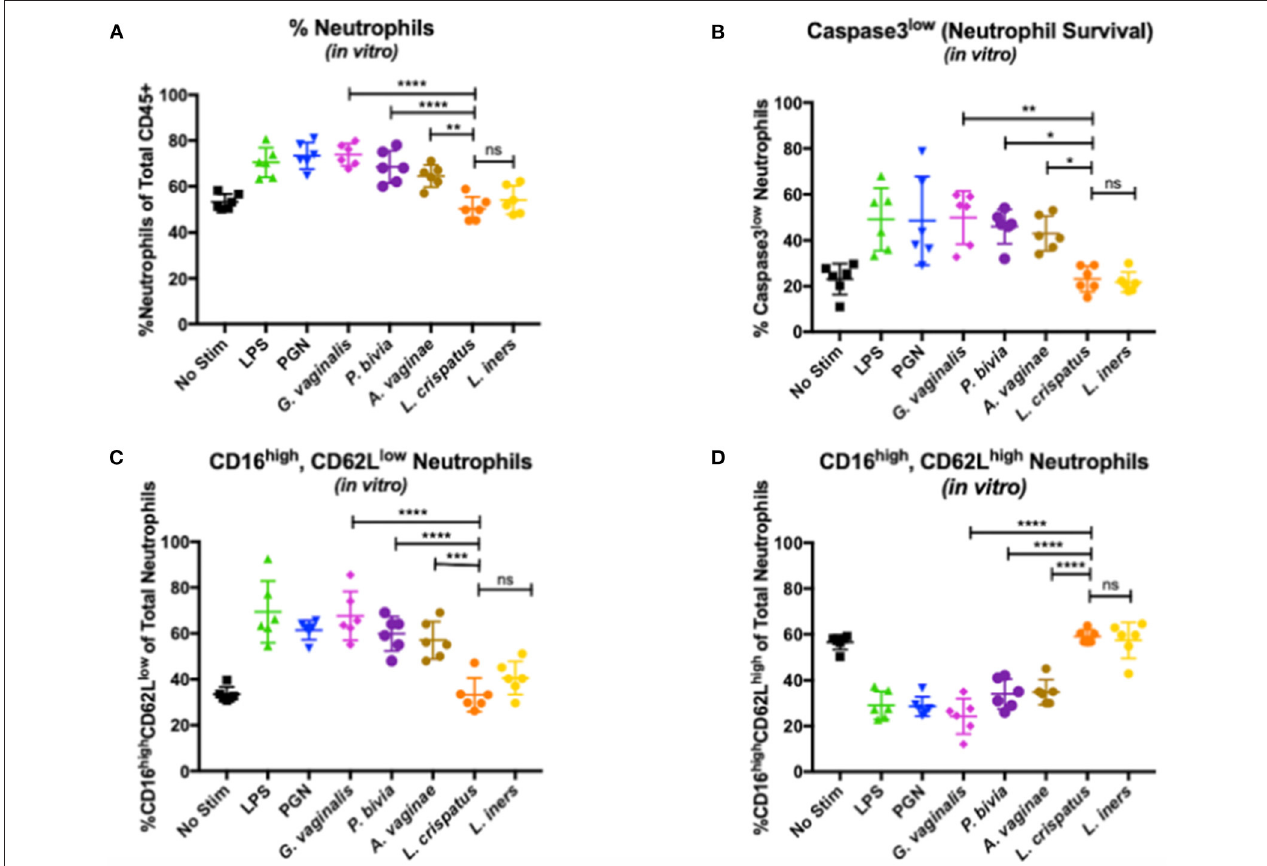
FIGURE 3 | Effects of vaginal bacteria on neutrophil frequency and phenotype. (A) Neutrophils as a percentage of total CD45 + leukocytes measured by flow cytometry. Higher frequency of neutrophils in co-cultures with G. vaginalis, P. bivia, and A. vaginae compared to samples cultured with L. crispatus (respectively p < 0.0001, represented as **** in the figure; p < 0.0001, represented as **** in the figure; and p = 0.0018, represented as ** in the figure). No significant difference between samples co-cultured with L. iners and L. crispatus ( p = 0.9321 represented as ns in the figure). (B) Active Caspase-3low as a percentage of total neutrophils measured by flow cytometry. Higher percentage of non-apoptotic neutrophils in samples co-cultured with G. vaginalis compared to samples cultured with L. crispatus ( p = 0.0021, represented as ** in the figure), P. bivia compared to samples cultured with L. crispatus ( p = 0.0126, represented as * in the figure) and A. vaginae compared to samples cultured with L. crispatus ( p = 0.0452, represented as * in the figure). No significant difference between samples cultured with L. crispatus and L. iners ( p > 0.9999, represented as ns in the figure) (C) CD16high, CD62Llow neutrophils as a percentage of total neutrophils measured by flow cytometry. Increase in CD16highCD62Llow neutrophils in samples co-cultured with G.vaginalis compared to samples cultured with L. crispatus ( p < 0.0001, represented as **** in figure), in samples co-cultured with P. bivia compared to samples cultured with L. crispatus ( p < 0.0001 represented as **** in figure) and in samples co-cultured with A. vaginae compared to samples cultured with L. crispatus ( p = 0.0004, represented as *** in figure). No significant difference between the co-cultures with L. crispatus and L. iners ( p = 0.7876 represented as ns in the figure). (D) CD16high, CD62Lhigh neutrophils as a percentage of total neutrophils measured by flow cytometry. Higher frequency of this neutrophils subset in samples co-cultured with L. crispatus compared to samples co-cultured with G. vaginalis ( p < 0.0001), in L. crispatus compared to samples co-cultured with P. bivia ( p < 0.0001) and in samples co-cultured with L. crispatus compared to samples co-cultured with A. vaginae ( p < 0.0001). All p -values < 0.0001 in (D) are represented as ****. No significant difference between the co-cultures with L. crispatus and L. iners ( p = 0.9996 represented as ns in the figure). Each symbol represents a biological replicate. Statistical differences in neutrophil frequencies between experimental conditions were determined